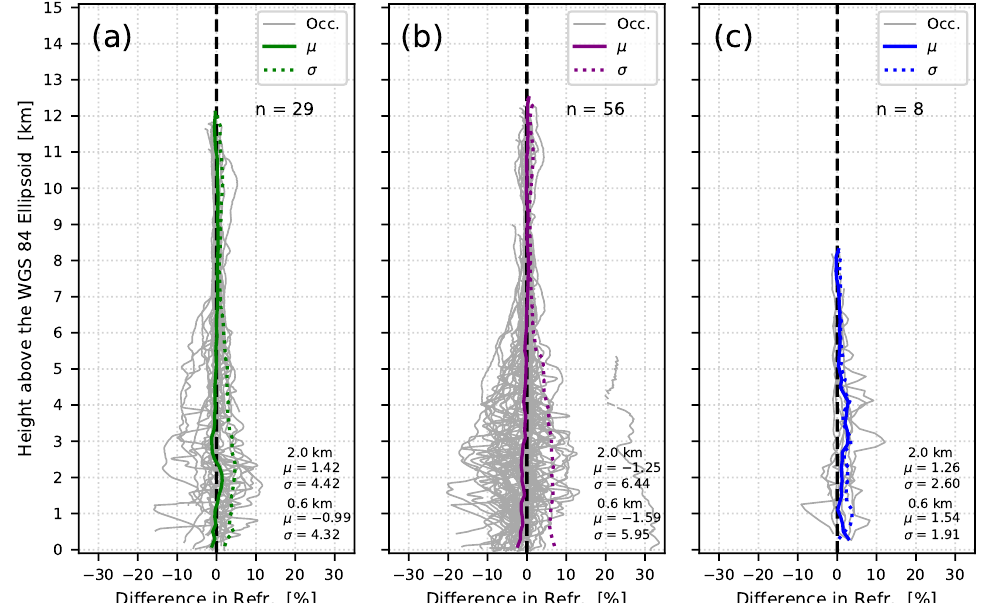
Figure 5. Statistical comparison between occultations and their nearest AR Recon dropsonde that was within a distance threshold of 300 km and a time threshold of 2 h. The percent difference in refractivity (% of N) is shown between each occultation in the ( a ) operational, ( b ) COSMIC-2, and ( c ) Spire dataset and its corresponding dropsonde profile (grey lines), along with the mean and standard deviation of these differences (solid and dashed colored lines, respectively) computed in vertical bins with width of 200 m. The thick dashed black line highlights the line of zero difference and the number of sample pairs, n, for each dataset is